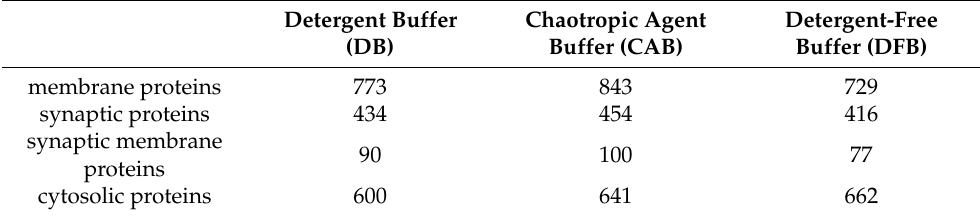
Table 2. Number of proteins, divided in GO categories, identified in each type of homogenate.